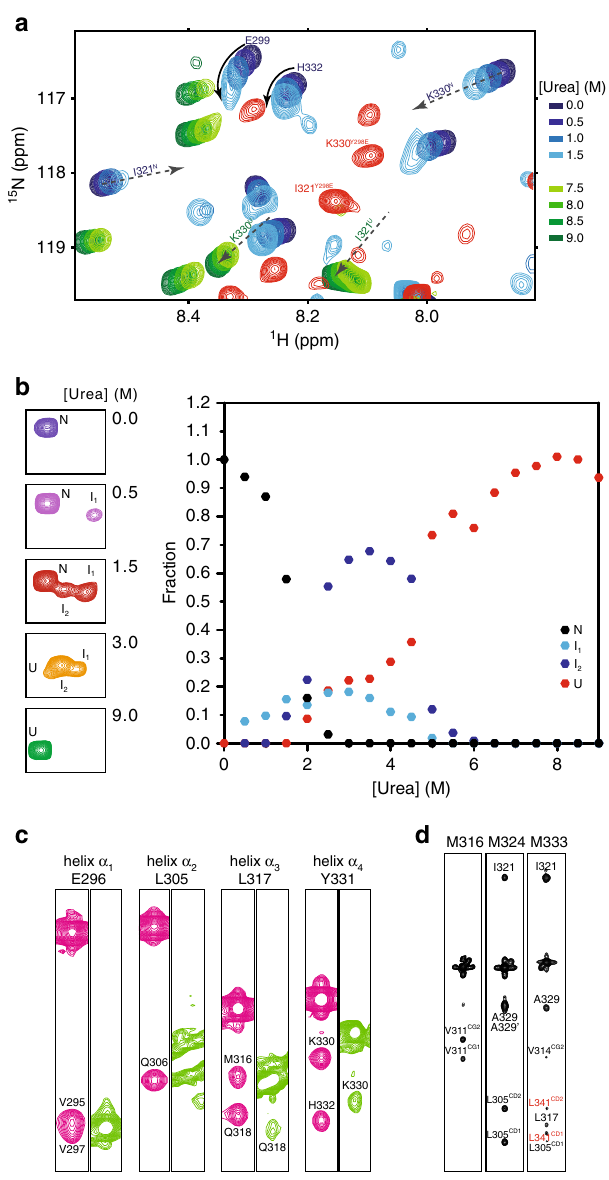
Fig. 3 Phosphorylated C-Cdc37 populates folding intermediates. a The beginning (0.0 – 1.5 M urea) and end (7.5 – 9.0 M urea) of the equilibrium unfolding of C-Cdc37 monitored by 15 N-HSQC. Arrows track the shift of signals from the native to the unfolded state. For I321 and K330 for which the signals of both the native and unfolded states are visible in this expansion, the superscripts N and U on the assignment denote native and unfolded states, respectively. For E299 and H332, the signals of the unfolded state fall outside the present spectral window, but show a “ curved ” change in chemical shift with increasing urea concentration. The spectrum of C-Cdc37 Y298E is shown in red for comparison highlighting the position of I321 and K330 signals. b The indole H – N region of wild-type C- Cdc37, highlighting the signals that correspond to W342 at different points of the equilibrium unfolding (left). Fractional populations of the four visible species populated by C-Cdc37 during the equilibrium unfolding as a function of urea concentration (right). c Selected strips from the amide region of the 15 N-NOESY-HSQC recorded for the wild-type C-Cdc37 (pink) and C-Cdc37 Y298E (green). Representative residues from all helices α 1 – α 4 are included. d Selected strips from the HMQC – NOESY – HMQC spectrum of C-Cdc37 Y298E , highlighting unambiguous (black) and tentative (red)